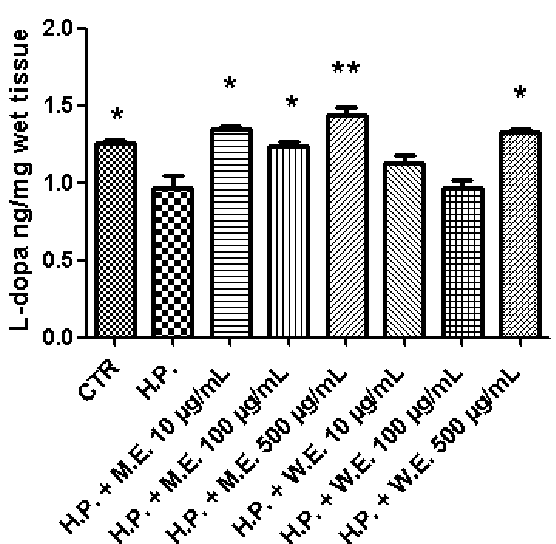
Figure 6. Effects of P. foetida methanol (M.E.) and water (W.E.) extracts on hydrogen peroxide 1 mM (H.P.)-induced decrease of l-dopa release from isolated mouse skin. l-dopa release was quantified through HPLC coupled to coulometric detection and expressed as ng/mg wet tissue. Data were analyzed through analysis of variance (ANOVA), followed by post hoc Newman-Keuls test. ANOVA, p < 0.001; * p < 0.05, ** p < 0.01 vs. H.P. Additionally, the extracts were also e ff ective in blunting hydrogen peroxide-induced level of PGE 2 (Figure 7). This also agrees with the calculated a ffi nity of apigenin, chrysoeriol, luteolin, quercetin, and loliolide towards COX-2.